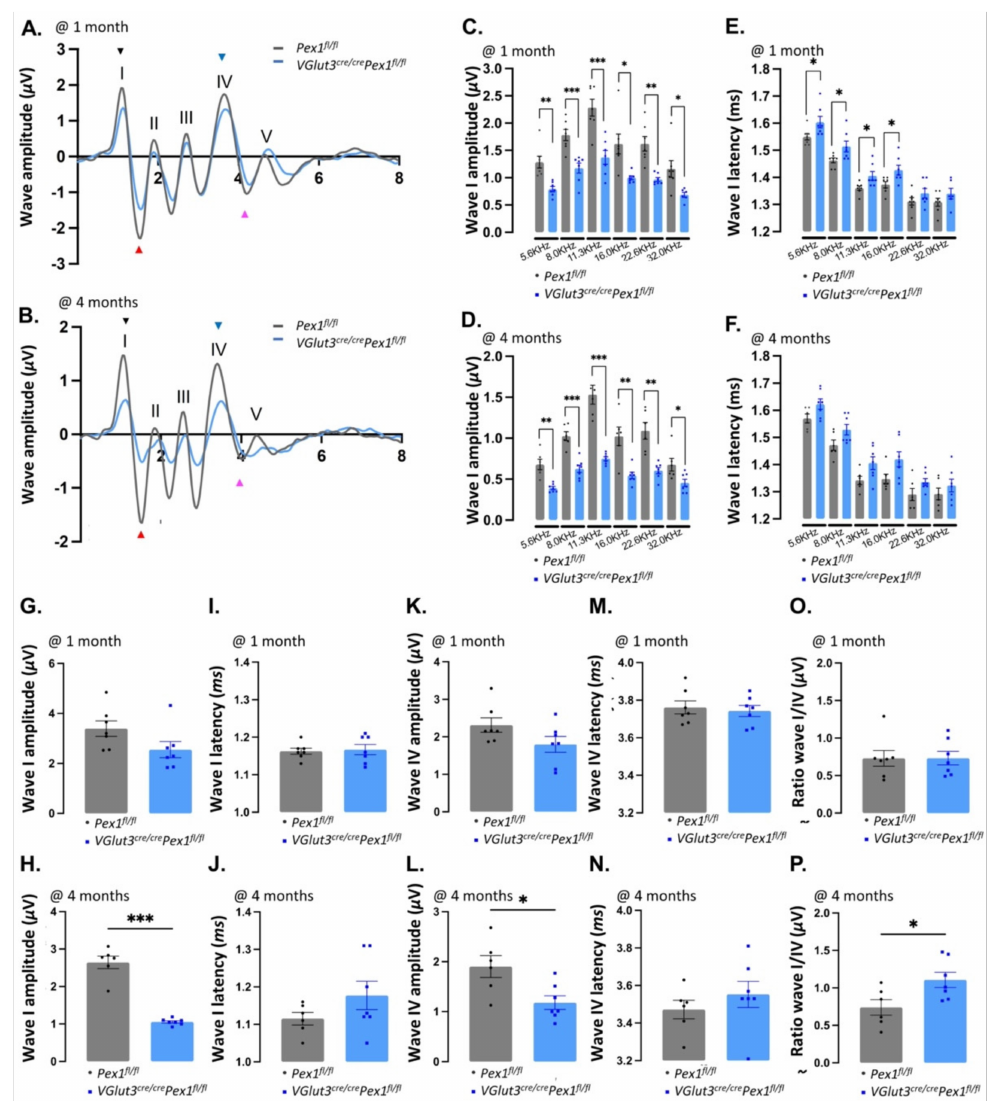
Figure 4. Wave I and IV amplitude are decreased in VGlut3 cre/cre Pex1 fl/fl . ( A , B ) Average of individual click ABR wave traces recorded on Pex1 fl/fl (grey) and VGlut3 cre/cre Pex1 fl/fl (blue) mice at 1